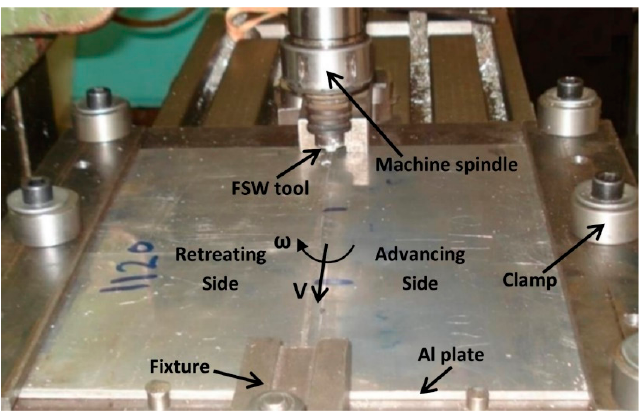
Figure 2. Schematic of the FSW process, the FSW tool in interaction with the AA1100 plates as the substrate.